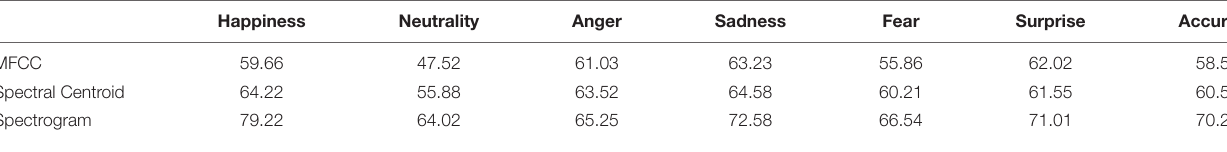
TABLE 3 | Comparison of classification accuracy of different audio